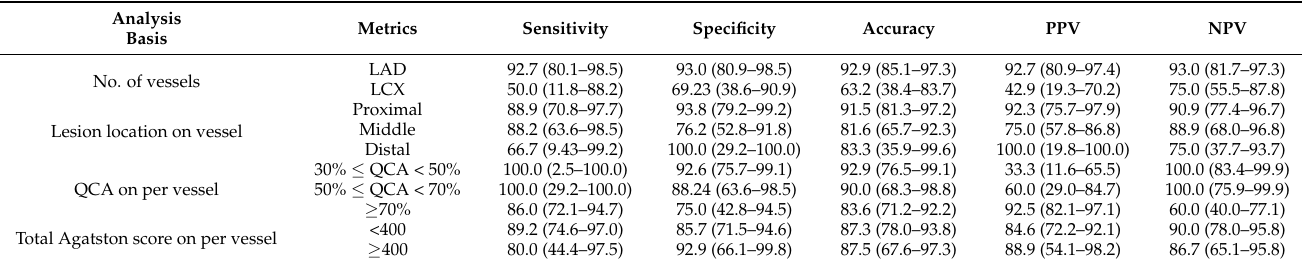
Table 3. Diagnostic performance of CTP-FFR ( ≤ 0.80) with different variables in determining myocar- dial ischemia with invasive fractional flow reserve as a reference standard ( ≤ 0.80) on a per-vessel basis.